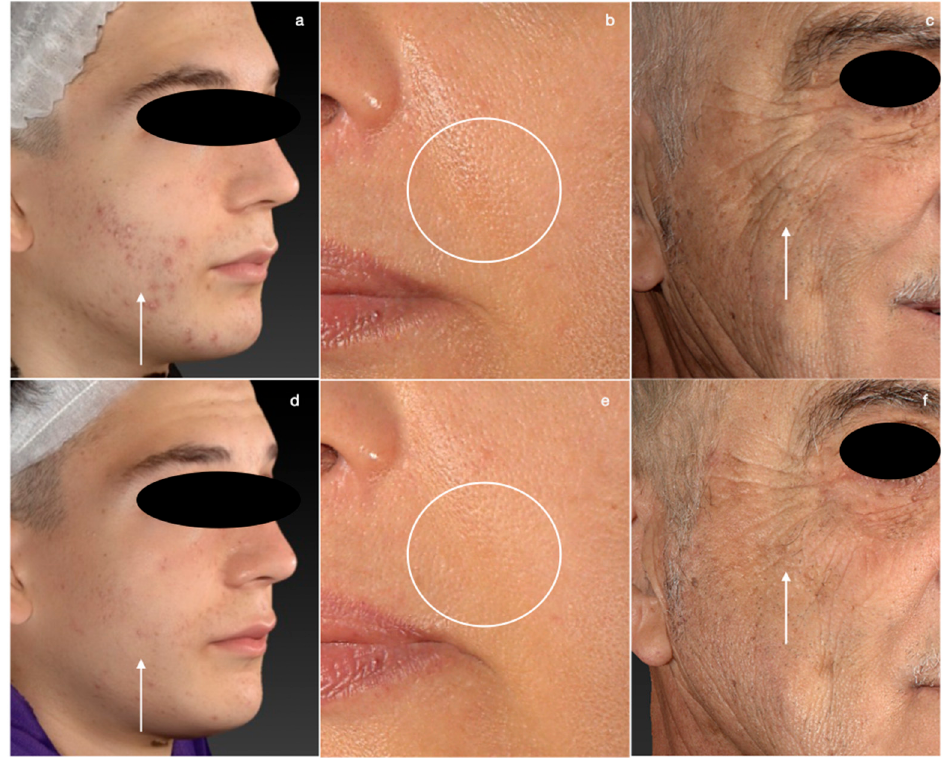
Figure 1. Mild acne before ( a ) and after ( d ) the carbon peel laser treatment; skin pores ( b ) of the nasolabial fold reduced after the protocol ( e ); deep wrinkles of the periocular area ( c ) and ( f ) improvement of thin and deep wrinkles of the face after the entire protocol.